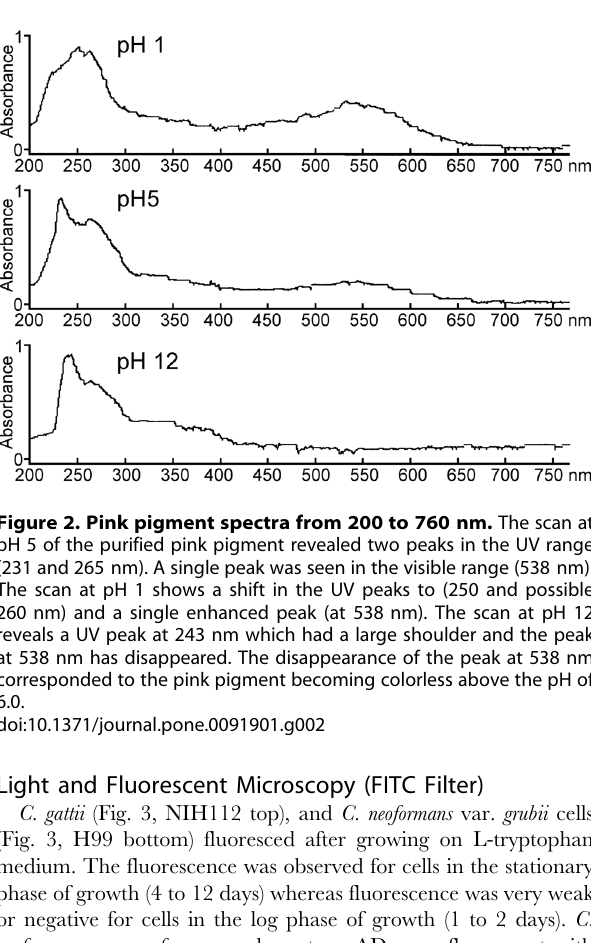
C. gattii (Fig. 3, NIH112 top), and C. neoformans var. grubii cells (Fig. 3, H99 bottom) fluoresced after growing on L-tryptophan medium. The fluorescence was observed for cells in the stationary phase of growth (4 to 12 days) whereas fluorescence was very weak or negative for cells in the log phase of growth (1 to 2 days). C.